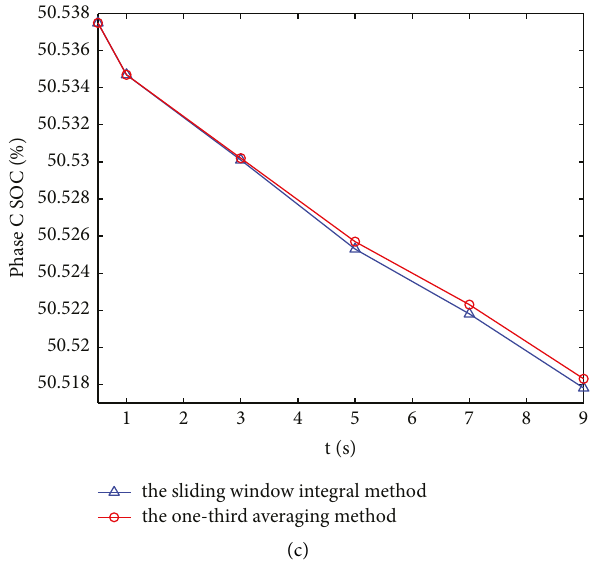
Figure 24: SOC average value of three phases of the MMC-BESS. (a) Sliding window integral method of phase A , SOC average using one- third average method. (b) Sliding window integral method of phase B , SOC average using one-third average method. (c) Sliding window integral method of phase C , SOC average using one-third average method. Table 5: Comparison of SOC data between one-third average method and sliding window integral method. Comparison of SOC